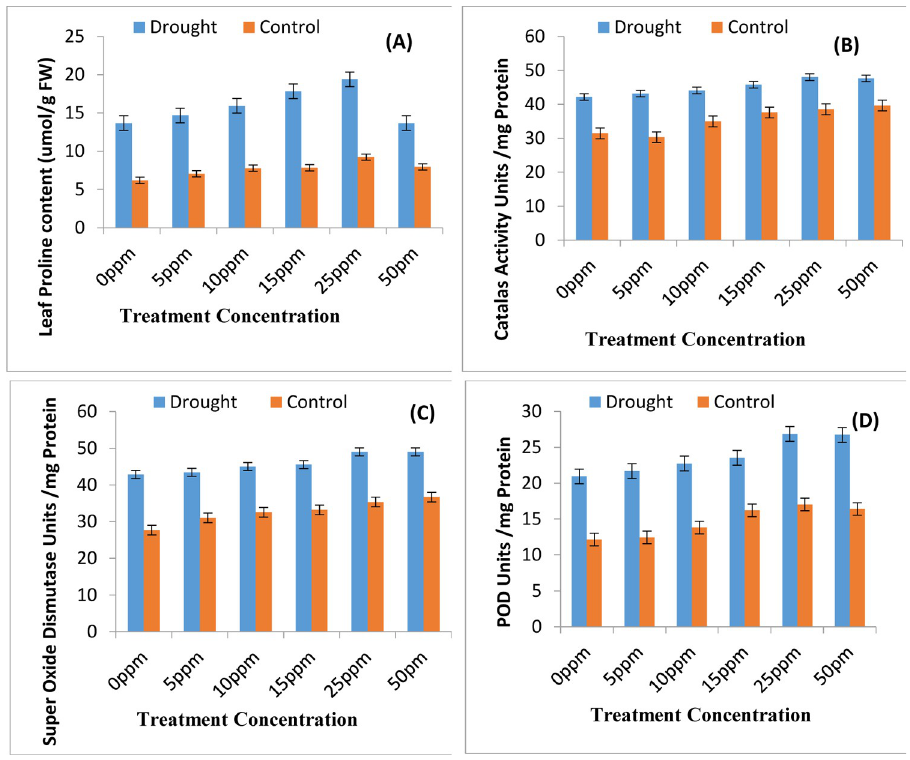
Fig 5. Values of some biochemical attributes and antioxidant enzymes activities in rice plants. (A) Proline values (B) Catalase (C) Super Oxide Dismutase (D) Peroxidase activities as affected by various regimes of ZnONPs under water scarce and well irrigated environment (mean ± SE; n =